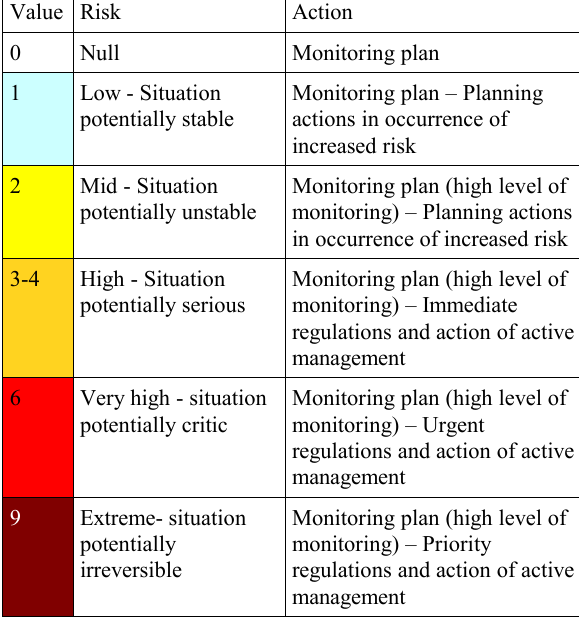
Table 3. Table for interpretation of risk; plan and action